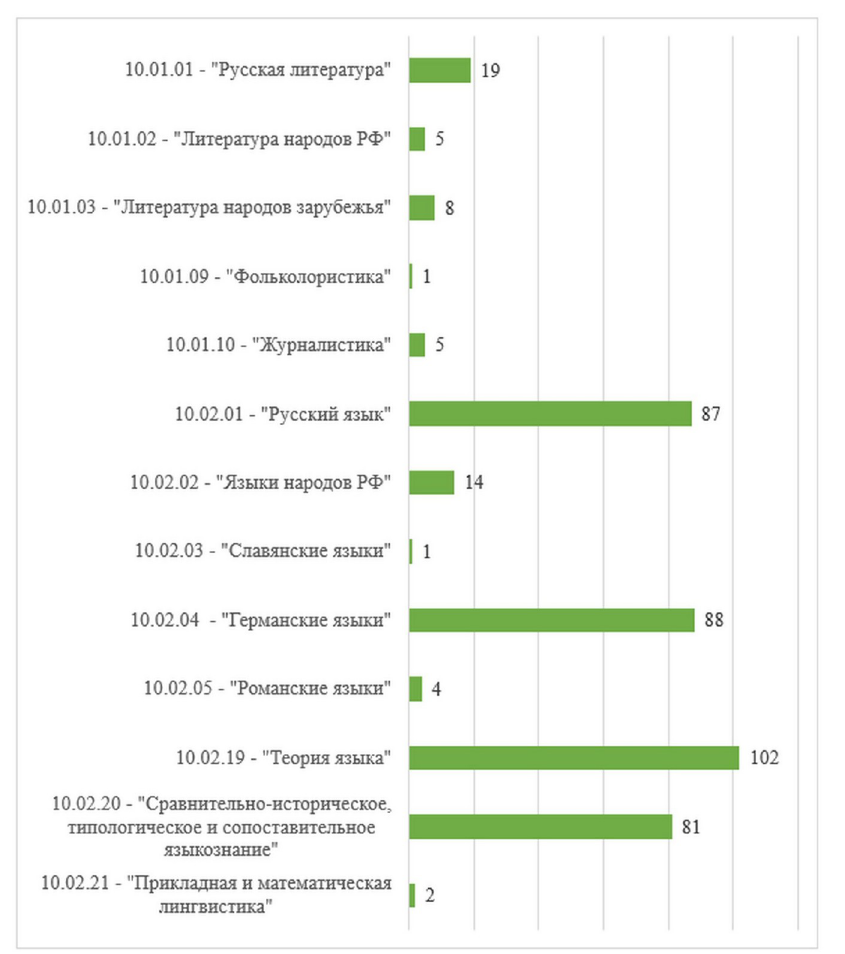
Рисунок 7 - Распределение диссертаций по специальностям